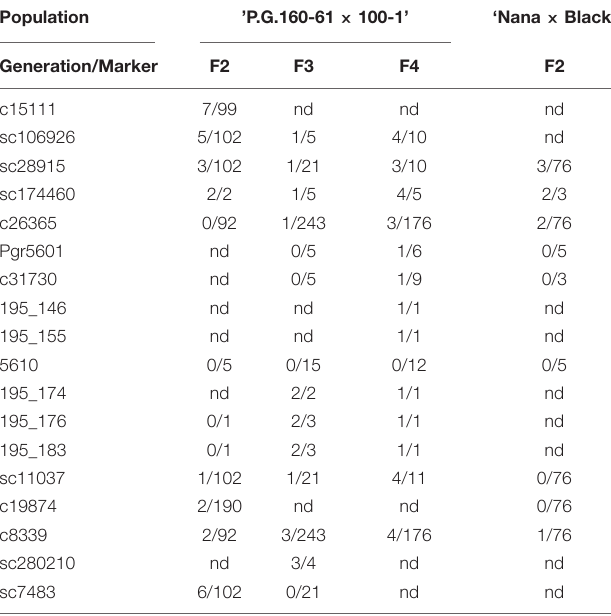
TABLE 2 | Recombinants between the evergreen trait and closed markers in four populations.